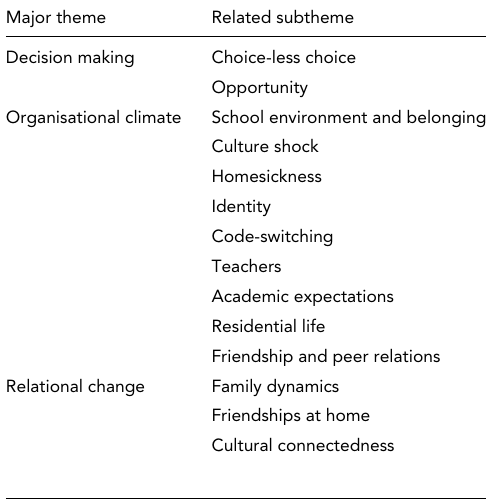
Major Themes and Related Subthemes for